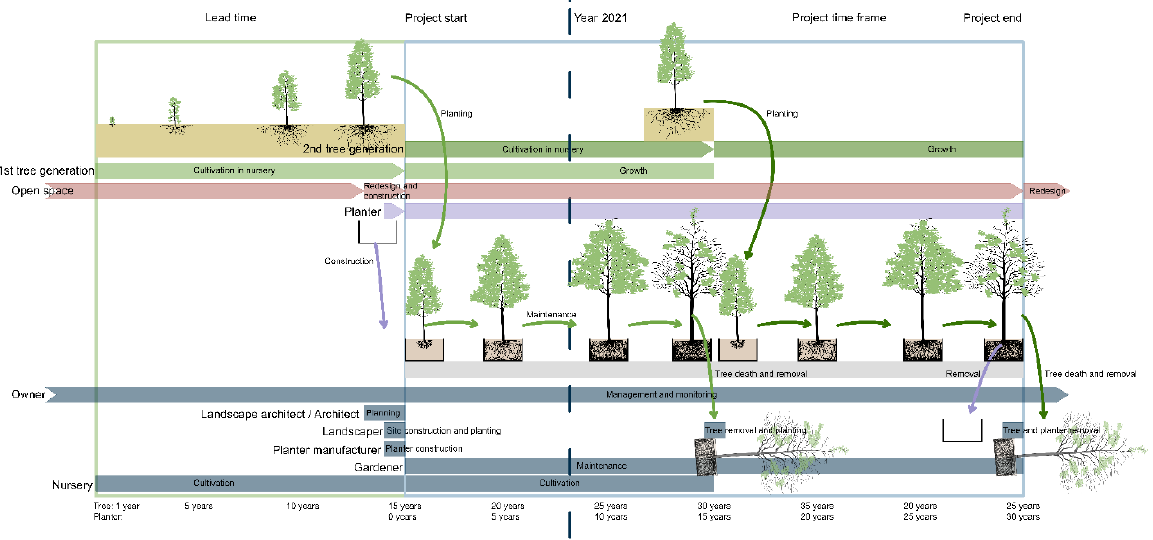
Figure 10. Time diagram of “Brown Hart Gardens”.